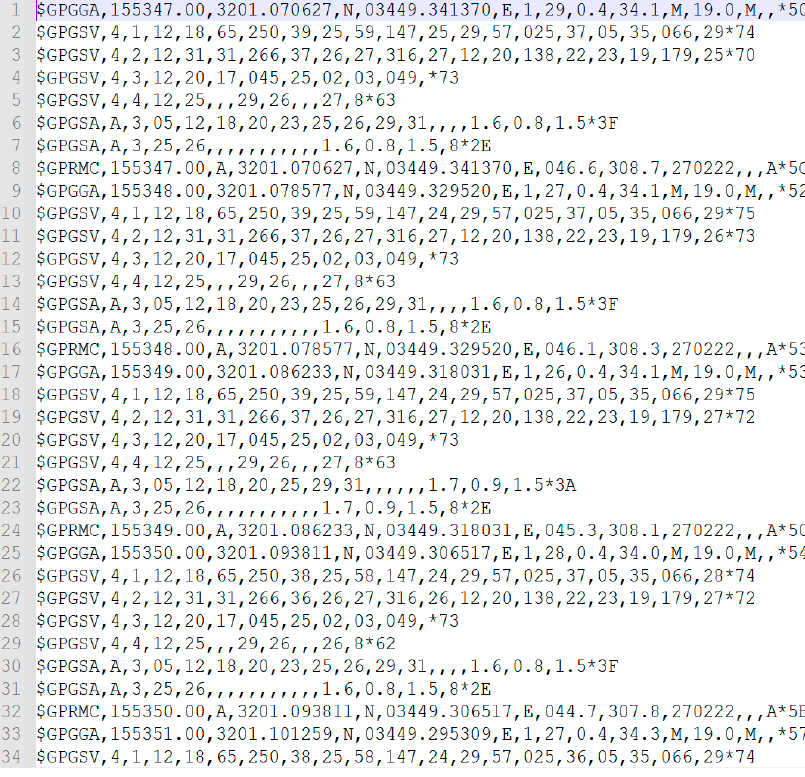
Figure A2. File after filtering.